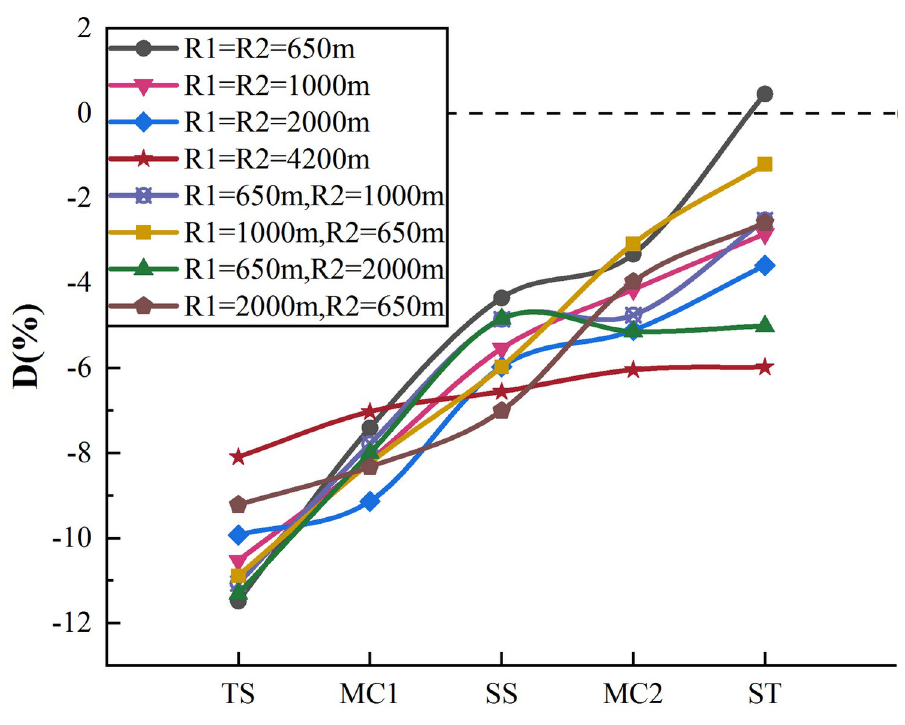
Fig 17. Perceived speed deviation diagram of s-shape